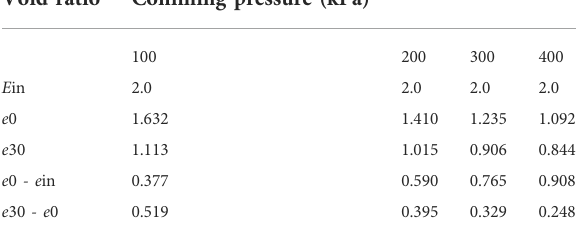
TABLE 2 Void ratio of MSW specimens, both before and after shear tests.